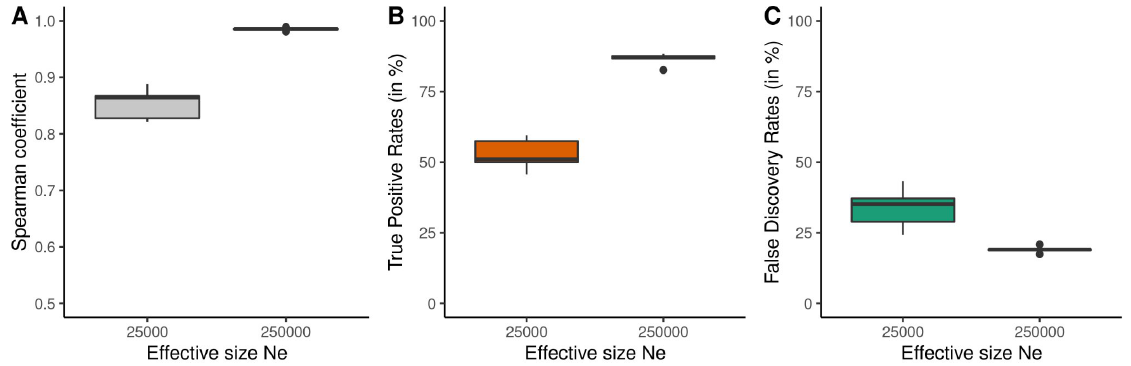
Figure 4 - Effect of the effective population size parameter (Ne) on recombination rate inference and hotspot detection. A) Spearman correlation coefficients between simulated and inferred landscapes as a function of N e (SS = 20, BP = 5). B) and C) True positive (TP) and false discovery (FD) rates of inferred, as compared to simulated hotspots, called using a detection threshold of 2.5, as a function of N e (SS = 20, BP = 5). See full results in Supplementary Figure S9 and